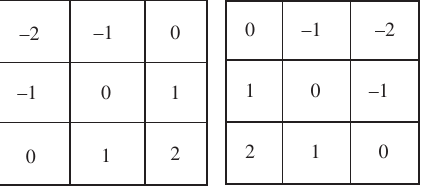
Figure 3: Templates of 45 ° and 135 ° of Sobel